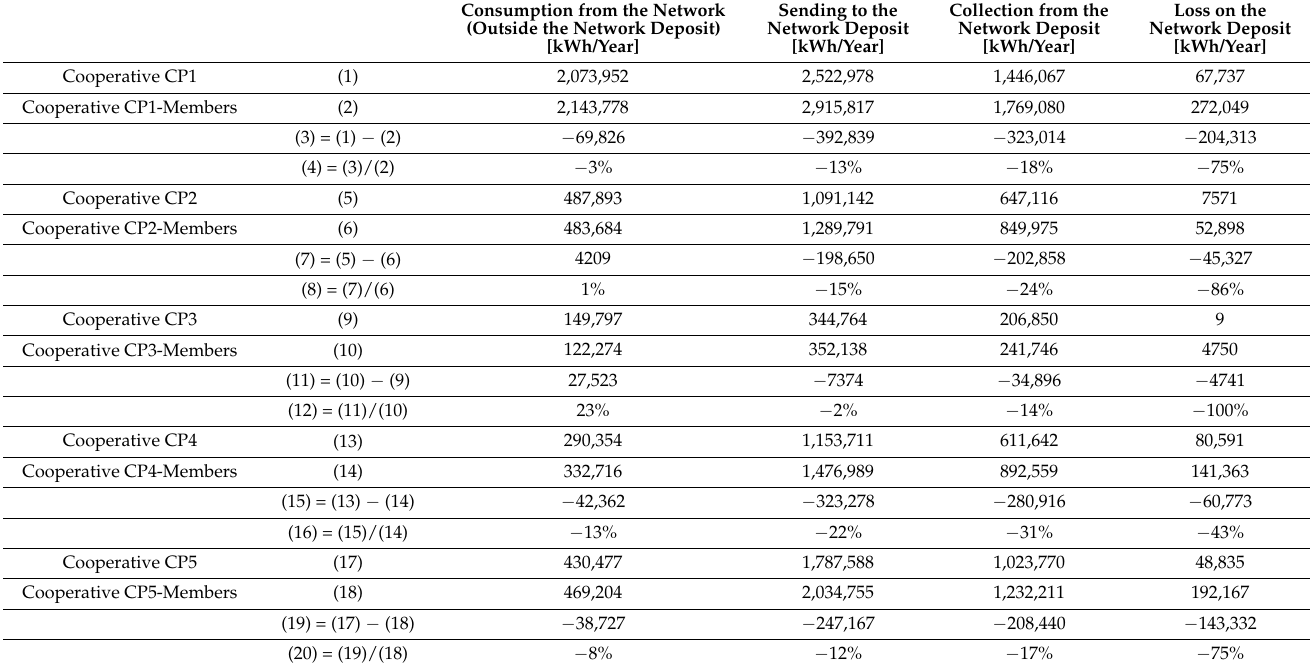
Table 3. Simulation results for cooperatives compared to theresults obtainedby aggregating partial results ofthe individual farms.